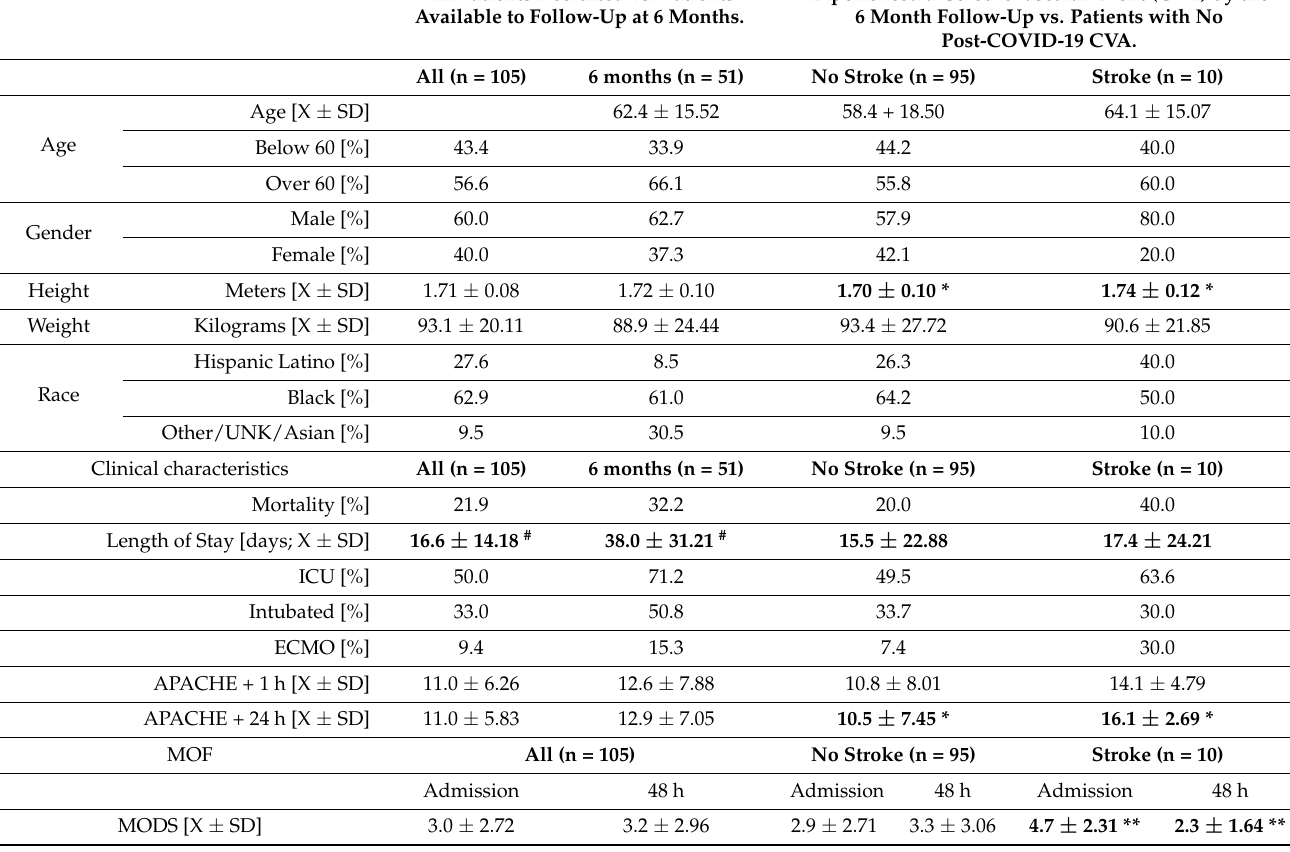
* Statistical difference when comparing patients with stroke vs. patients without stroke. ** Statistical difference when comparing patients at admission vs. patients at 48 h from admission. # Statistical difference when comparing patients at admission vs. patients at 6 months from